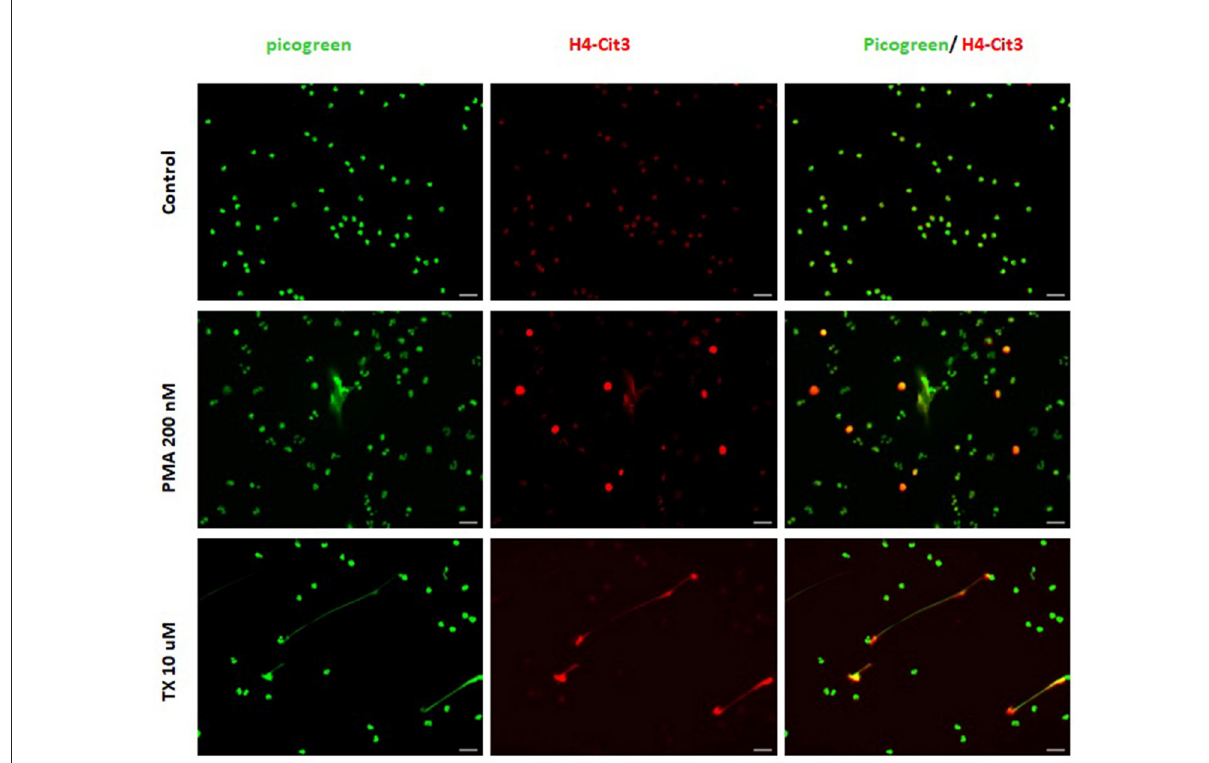
FIGURE2 Tamoxifen (TX) stimulates equine PMNs NETosis. Representative fluorescence of equine PMNs treated with TX (10 µ M) or PMA (200nM) and marked with DNA staining PicoGreen TM . Strand-like NETs structures marked with PicoGreen TM (green) and citrullinated histone H4 antibody (red) for control and treated cells with TX (10 µ M) and PMA (200nM). Scale bars = 30 µ m.